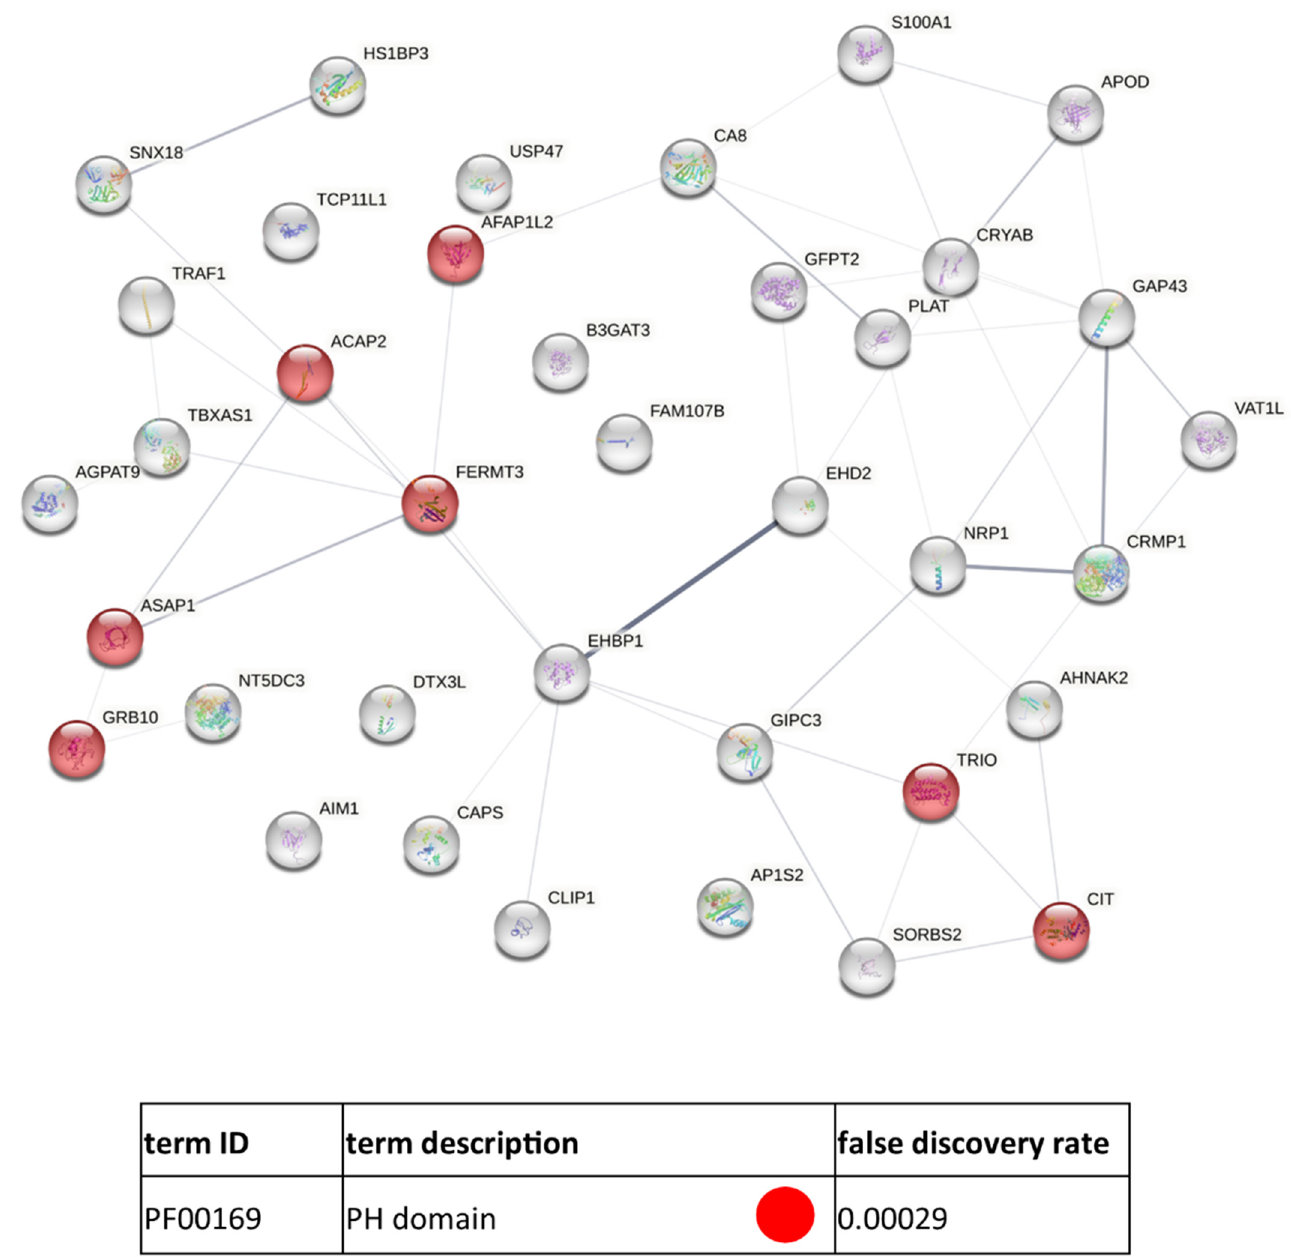
Figure A3. Diagram of functional protein association networks prepared with the use of STRING v. 11.0 software for proteins identified in WM1205Lu cells but not found in any replicates of WM793 cells. The selected, strongly represented pathways are presented as an interactome. A complete analysis is presented in Supplementary Data S3.